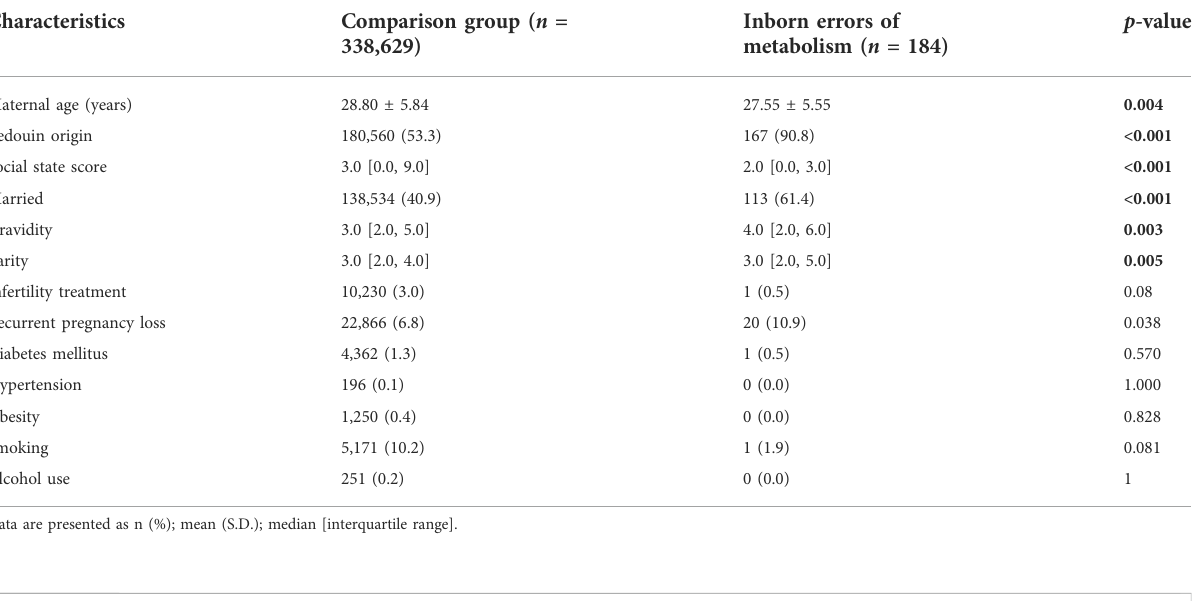
TABLE 1 Maternal demographic and pregnancy characteristics.